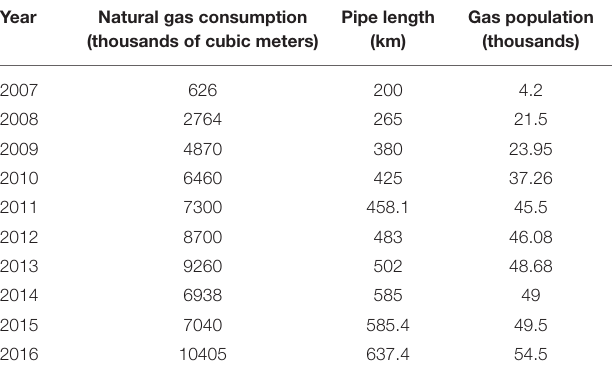
TABLE 1 | Overview of the natural gas system in Fuyang City from 2007 to 2016.